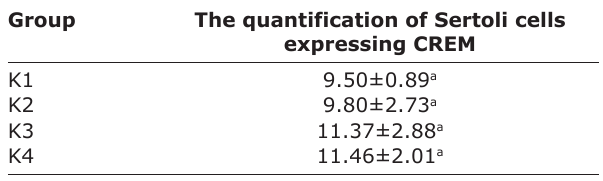
Table 1: Average CREM expression in Sertoli cells after administration of the seminal vesicle extract for 60 days. Group